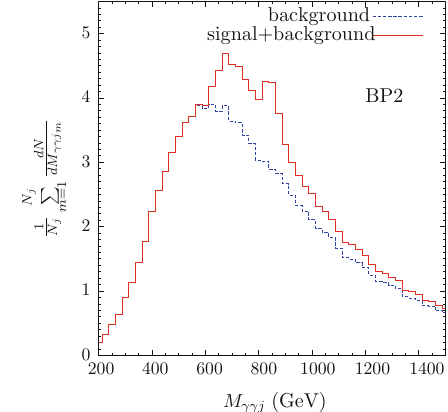
Fig. 7 The average of invariant mass distributions of the leading two photons with a jet for